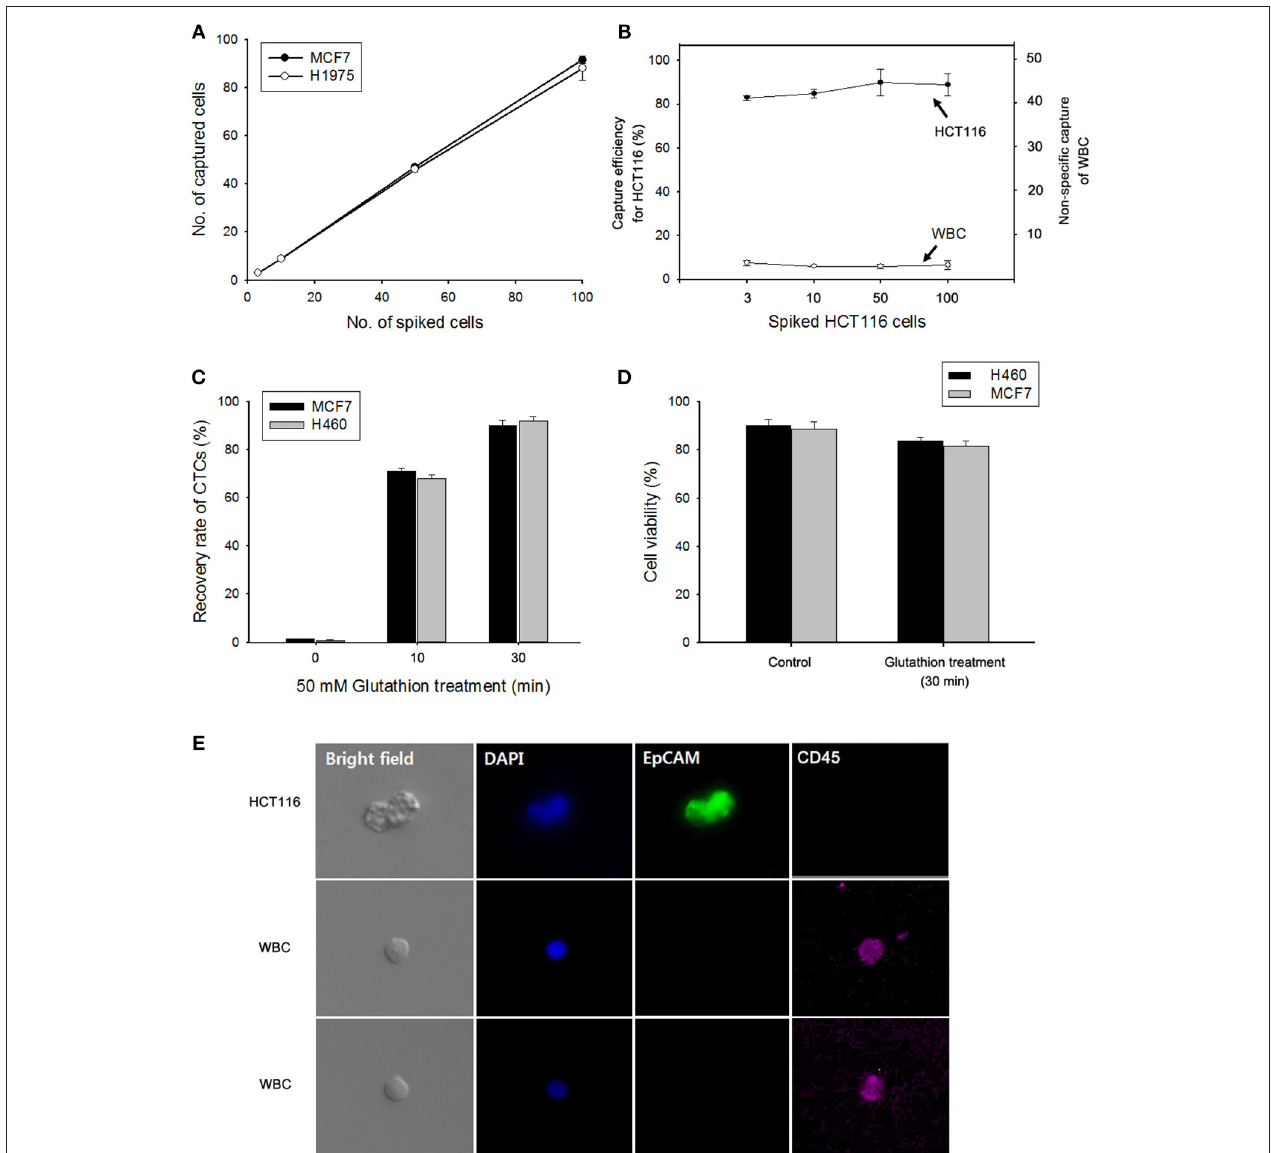
FIGURE 4 | (A) Evaluation of cell capture efficiency of the nanowire (NW) platform by spiking MCF7 and H1975 cells into 1mL of human blood. (B) Capture efficiency of HCT116 cells and nonspecifically bound WBCs under different numbers of spiked cancer cells. (C) GSH-mediated release of the captured MCF7 and H460 cells from the NW platform at various time points. (D) Assessment of the viability of H460 and MCF7 cells detached upon GSH treatment. (E) Fluorescent micrographs of GSH-triggered cell release from artificial blood samples using a three-color immunocytochemistry method. MCF7 cells were distinctly stained with anti-EpCAM (green) and DAPI (blue), but negatively stained with anti-CD45 (red). Data are shown as mean ± standard deviation ( n = 5).